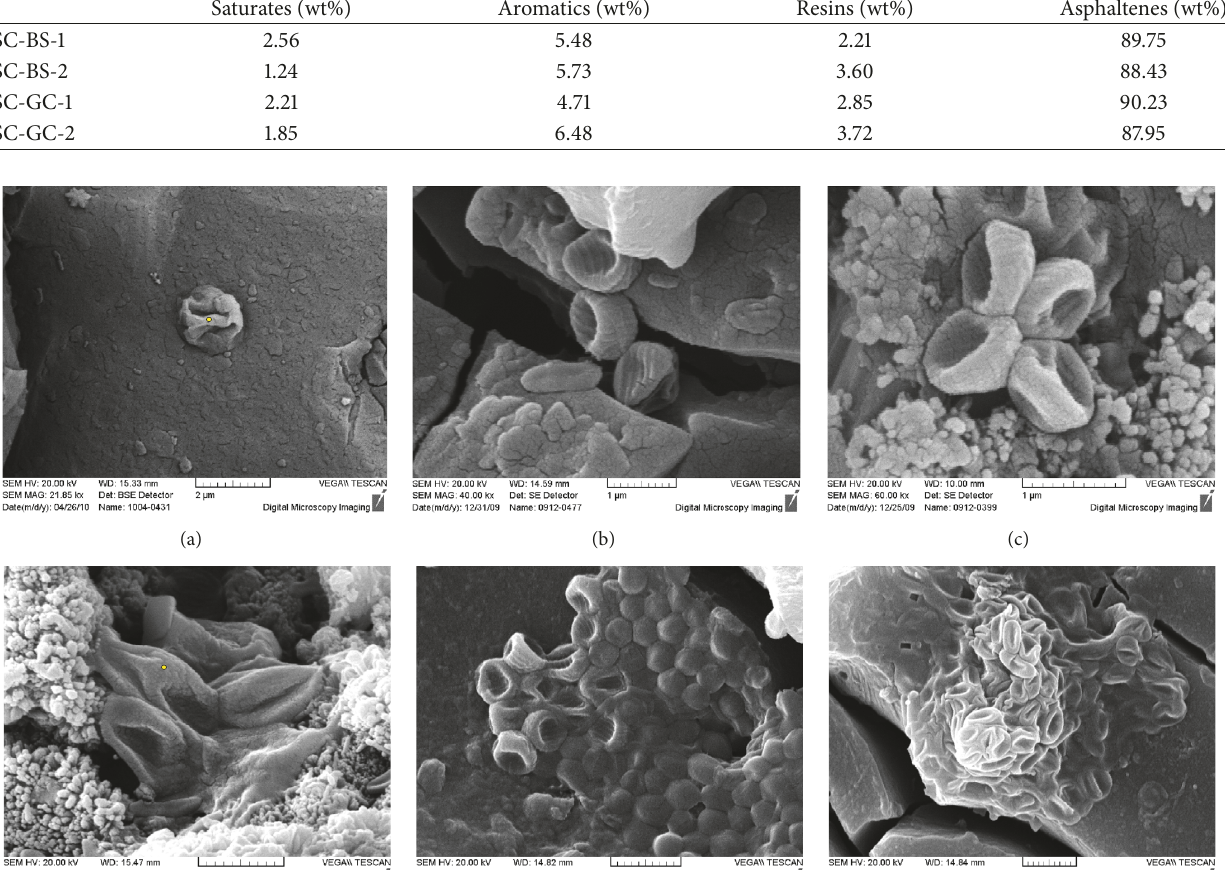
Category 2a: Straight Rod and Round End (Figures 6(a)–6(c))